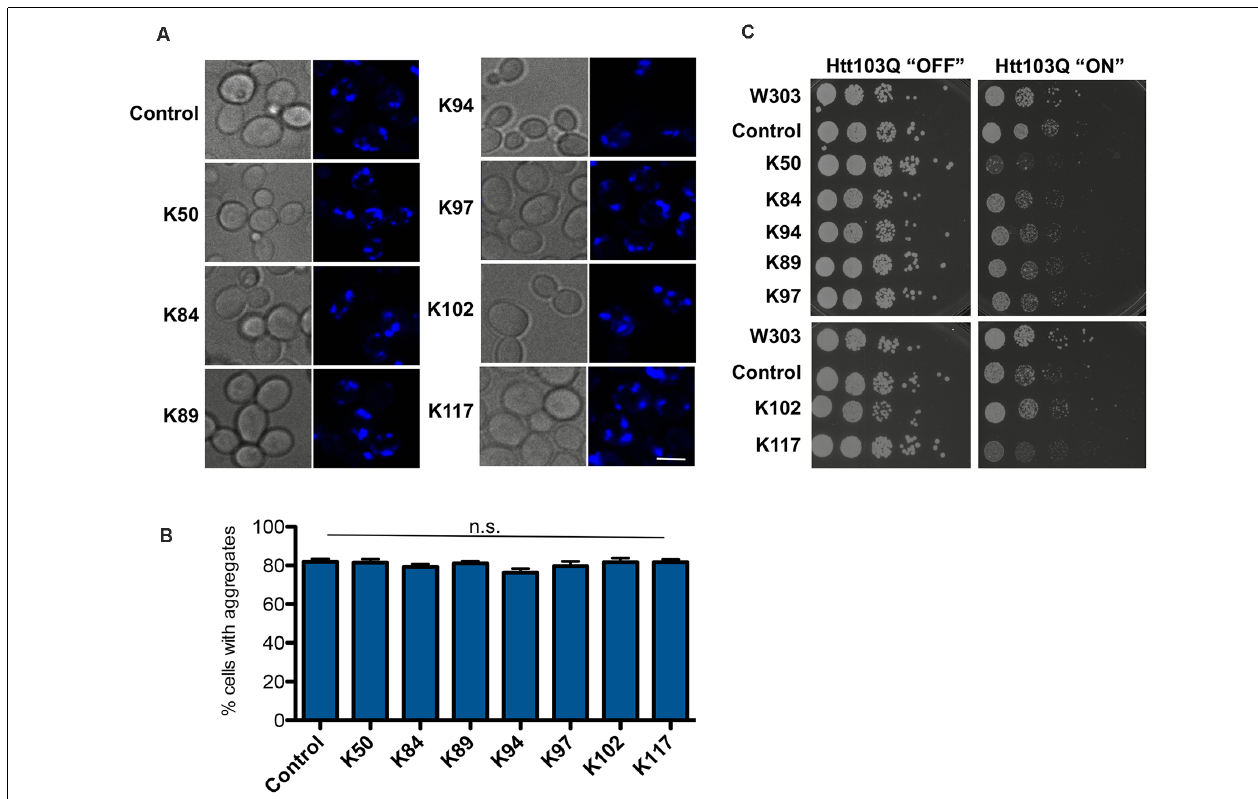
FIGURE 4 | Huntingtin-103Q aggregation and cellular yeast growth phenotypes are independent of the presence of α Syn-specific peptides. (A) Life cell microscopy of yeast strain RH3788, co-expressing huntingtin construct with 103 PolyQ repeats (Htt103Q ∆ Pro-CFP) and the indicated peptide constructs or empty vector as a control. Yeast cells, pre-grown to mid-log phase, were induced in galactose-containing medium and examined for aggregates at 6 h of induction. Expression of the Htt103Q variant revealed the formation of fluorescent foci. Scale bar: 5 µ m. (B) Aggregate quantification of yeast cells, expressing Htt103Q construct. For each strain, the number of cells displaying cytoplasmic foci is presented as a percent of the total number of cells counted. For quantification of aggregation at least 200 cells were counted. (C) Yeast cells from (A) were spotted in 10-fold dilutions on selection plates containing glucose (Htt103Q “OFF”) or galactose (Htt103Q “ON”) for induction of GAL1 promoter. W303—wildtype yeast background strain, transformed with empty vectors. Control: Htt103Q ∆ ProCFP strain, transformed with empty vector. n.s.: not